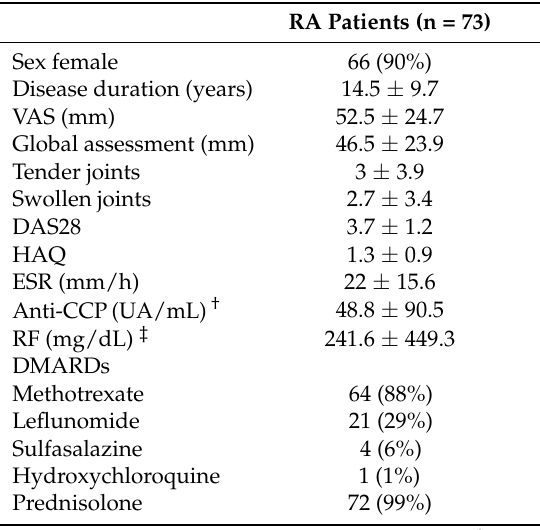
Table 1. Disease characteristics in RA patients.